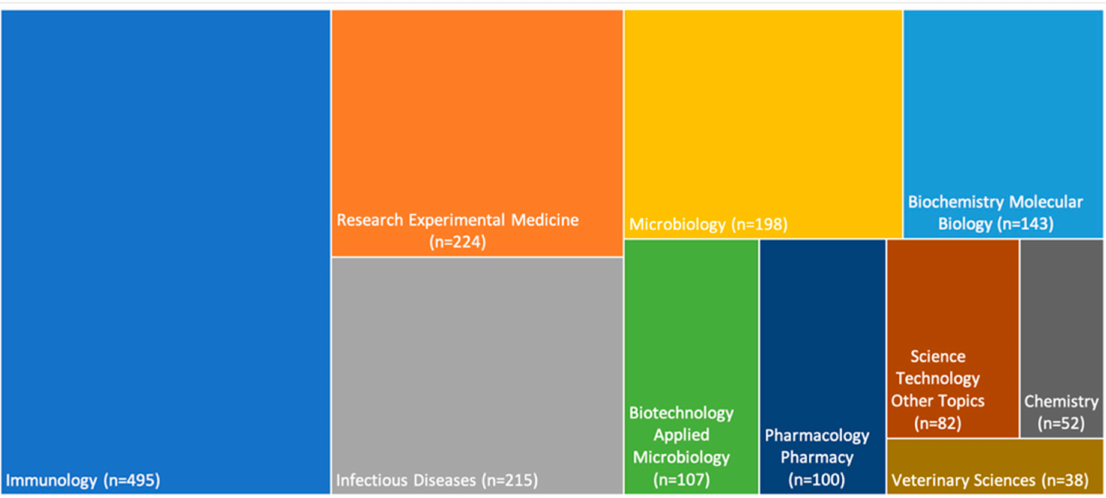
Figure 3. The most studied research areas in anthrax vaccine between 1991 and 2021.